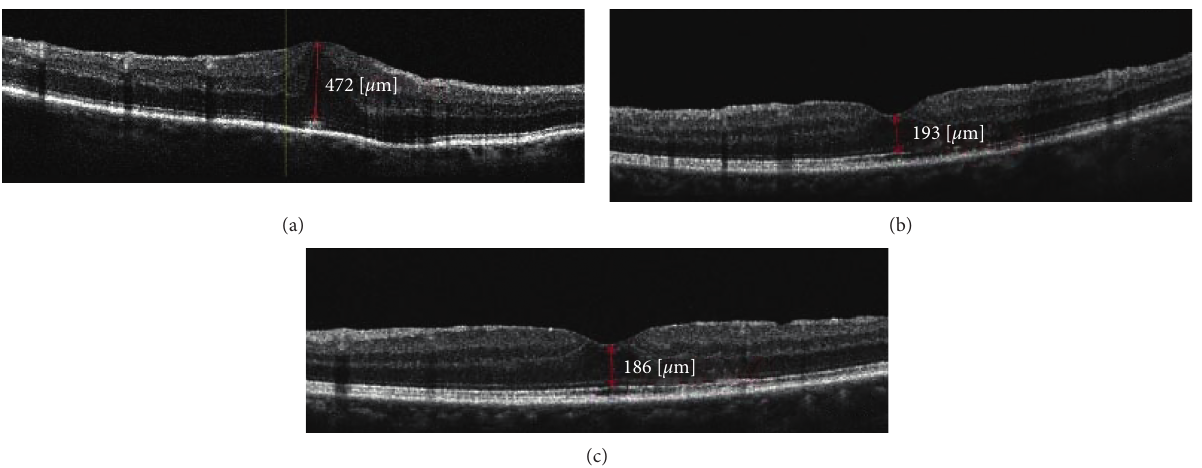
Figure 1: OCTscan of patient with limited vitrectomy with ERM removal. ((a)) Preoperative scan showing ERM with CMTof 472 μ with BCVA measuring 0.5 logMAR. ((b)) A one-month postoperative scan showing reduced CMT of 193 μ with BCVA improving to 0.8. ((c)) Yearly follow-up scan showing CMT 186 μ with normal foveal contour and vision improving to 0.9 logMAR.